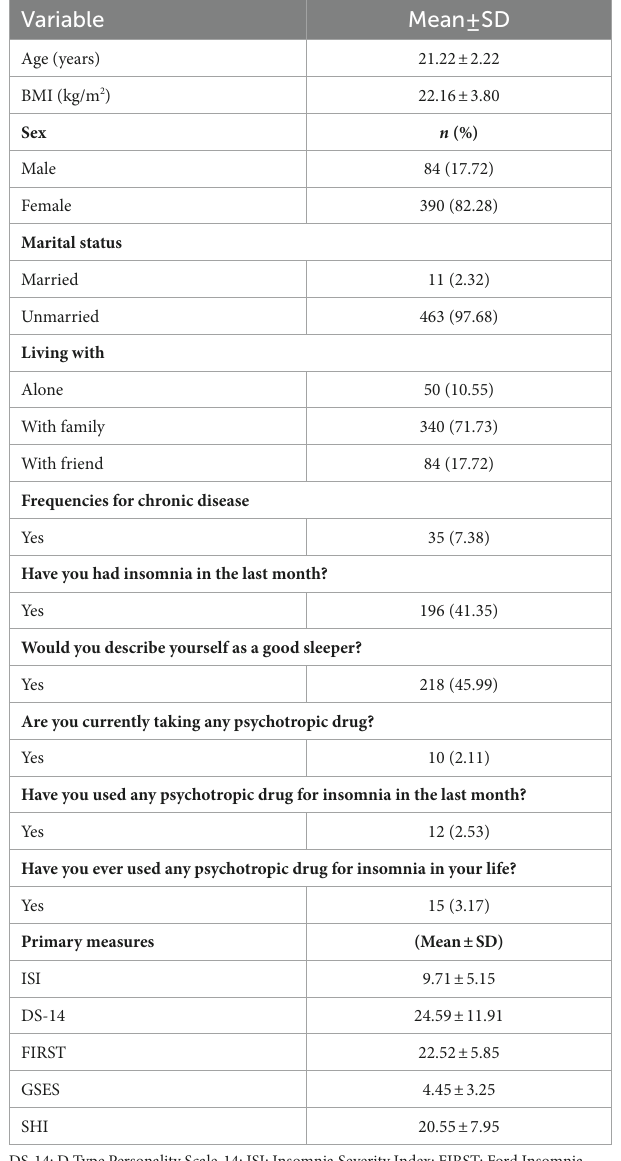
TABLE 1 Sociodemographic and clinical variables of all